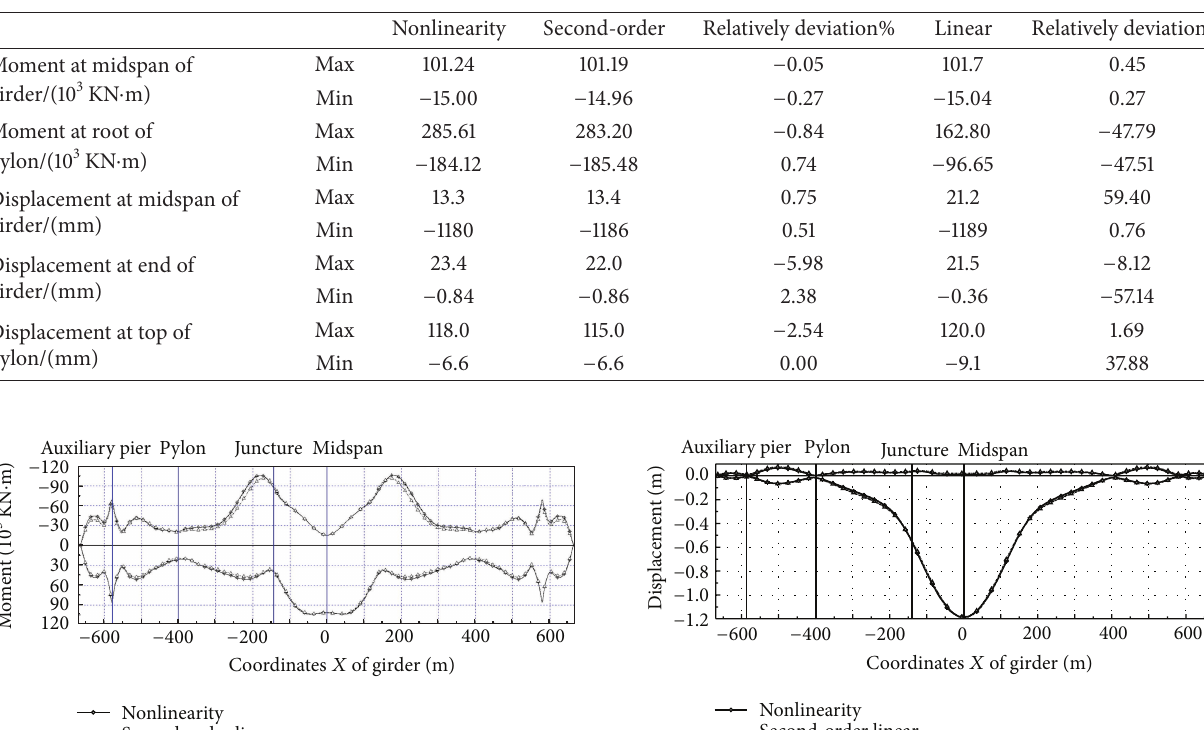
Figure 1: Arrangement diagram of Dalian Gulf Bridge/m. Table 1: Nonlinear effect of live load.